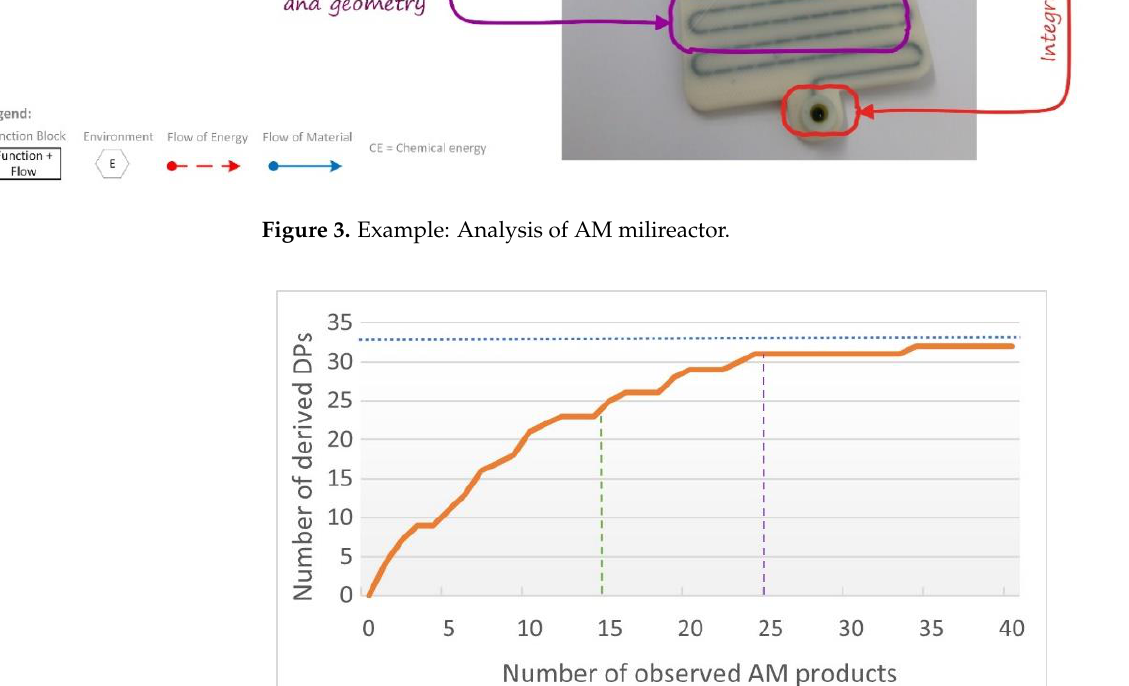
Figure 4. Convergence of derived design principles.